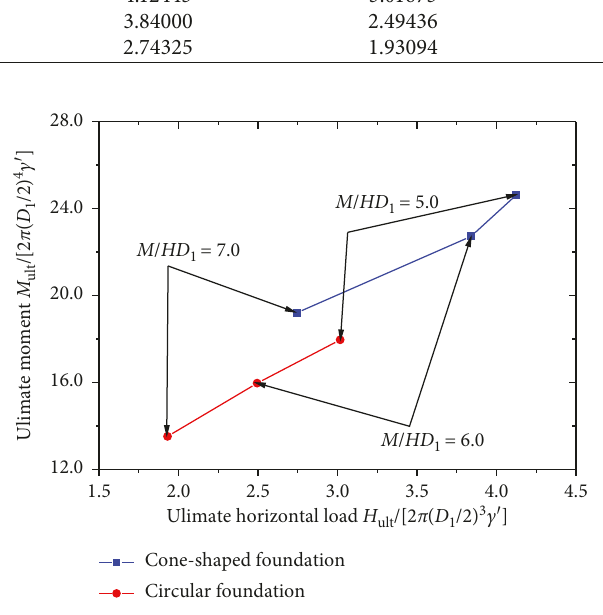
Figure 9: H - M interaction